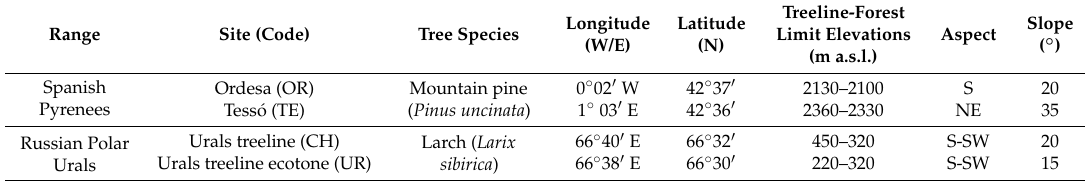
Table 1. Main features of the studied Mediterranean (OR, TE) and Polar (CH, UR) treelines.